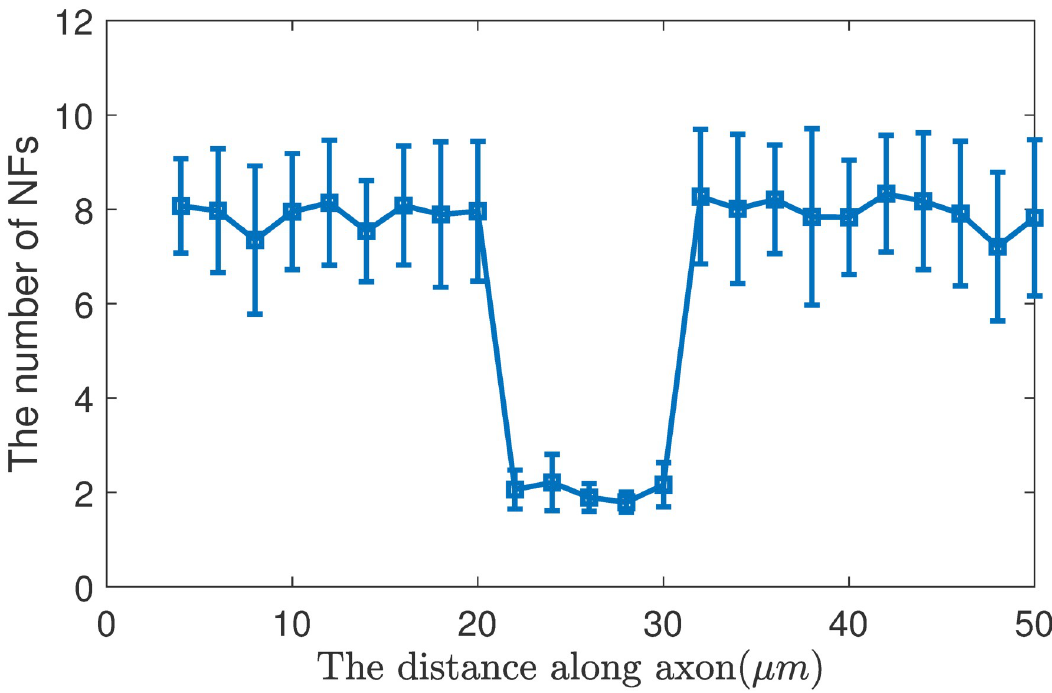
Fig 1. Distribution of NFs along axon in the ‘6-state’ model with kinetics of phosphorylation and dephosphorylation.